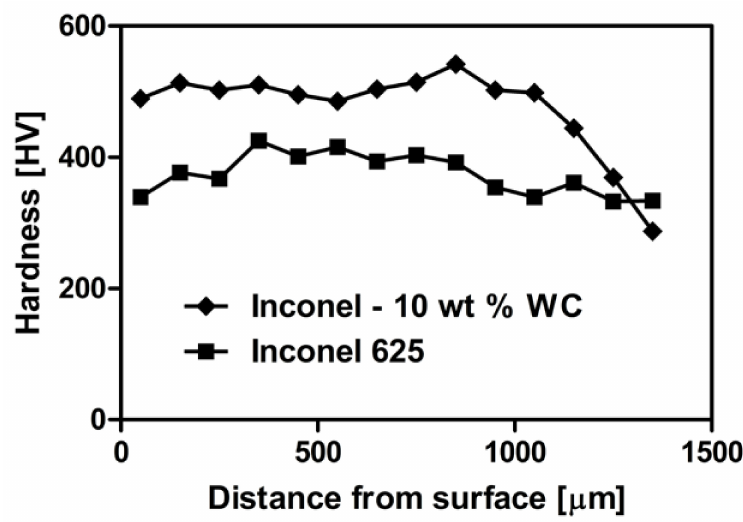
Figure 10. Vickers hardness of Inconel 625–WC coating and pure Inconel